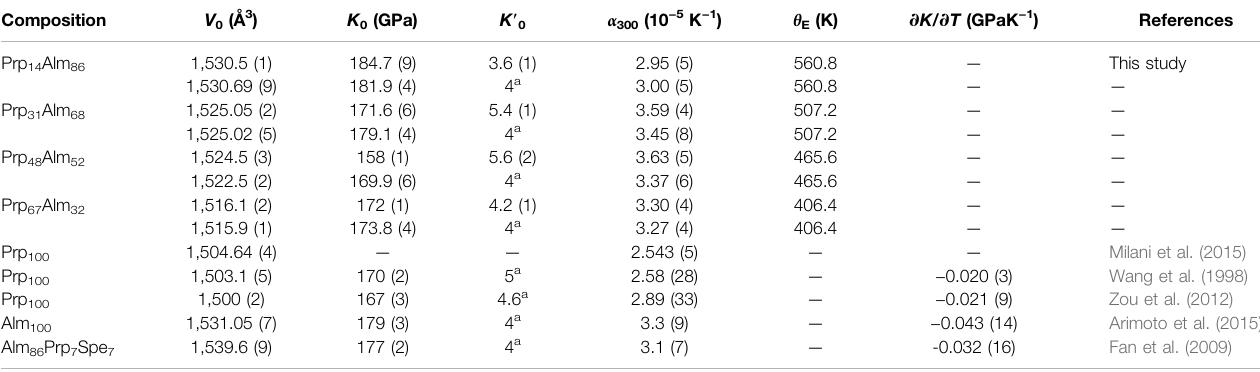
TABLE 2 | Thermoelastic parameters of garnets along the Prp-Alm join, as compared with previous studies. Composition